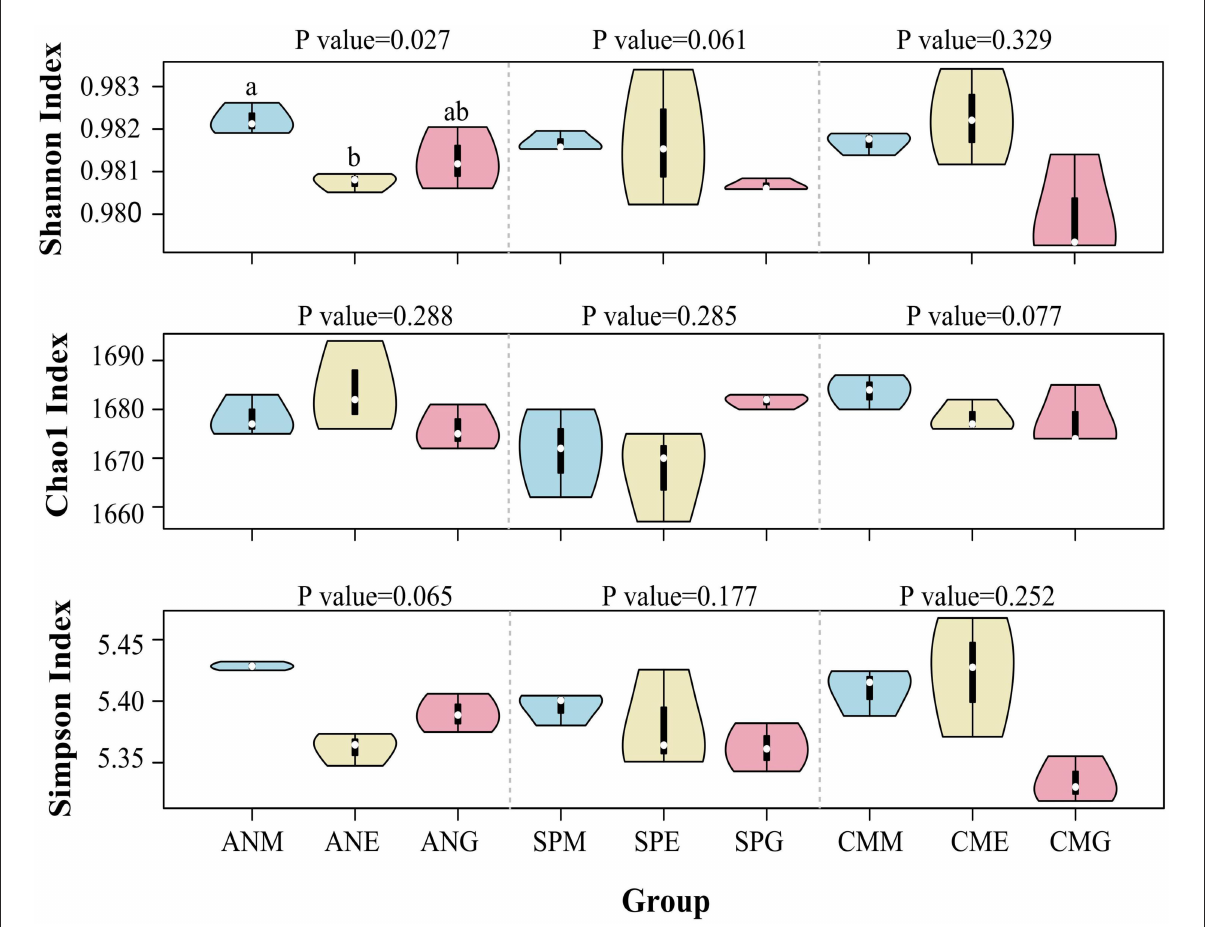
FIGURE5 Violin diagram based on alpha diversity indices. Groups with significant differences are marked with letters, while groups without a letter did not show significant